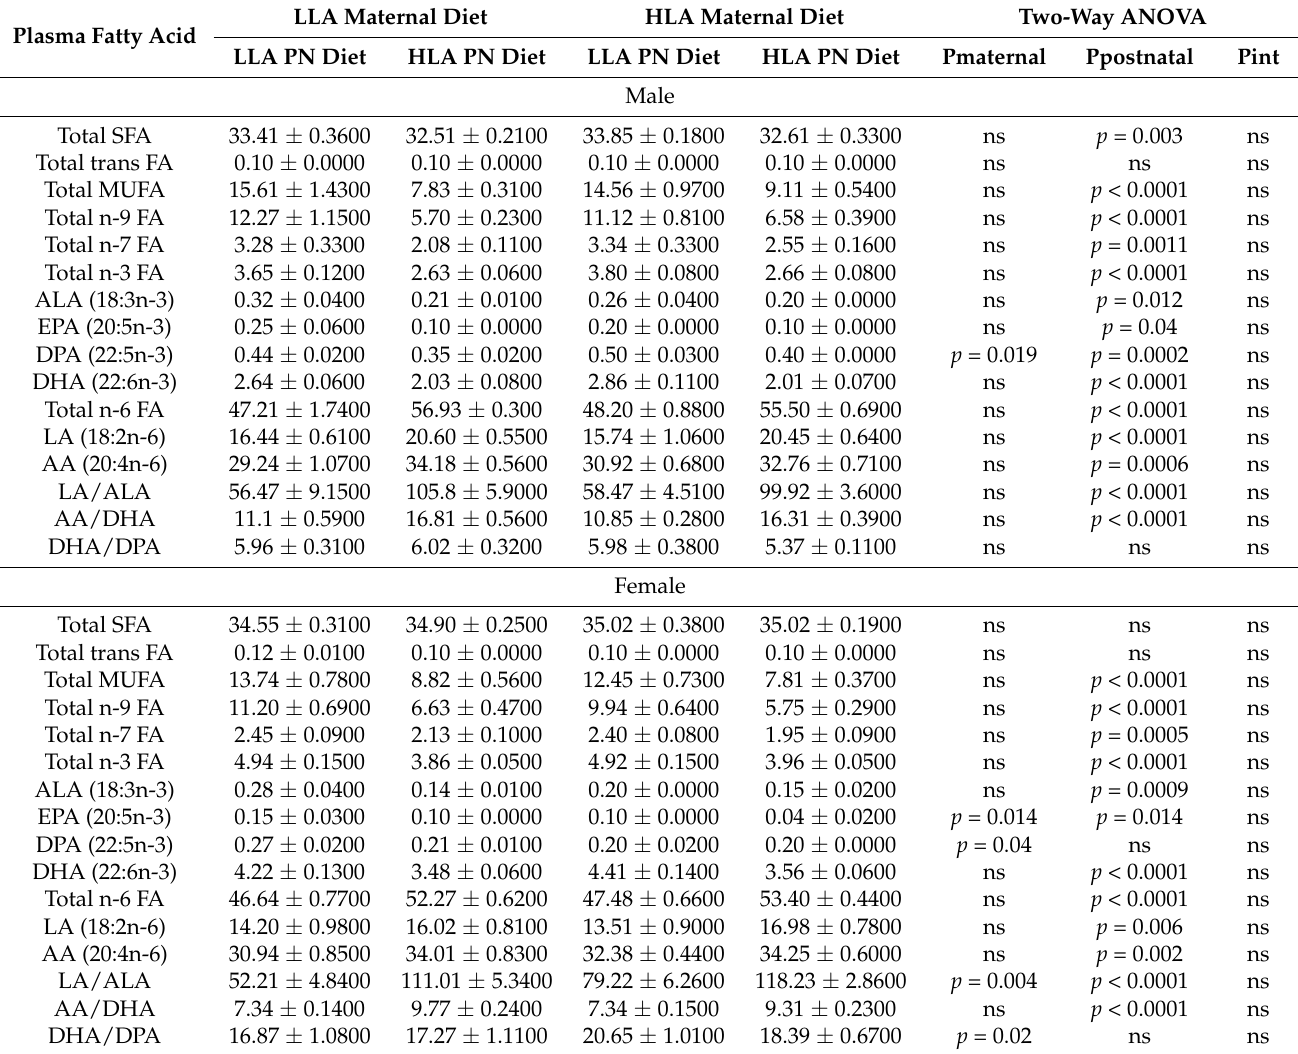
Table 2. Effect of a maternal and postnatal diet high in linoleic acid on plasma fatty acid composition in adult offspring. LLA Maternal Plasma Fatty Acid